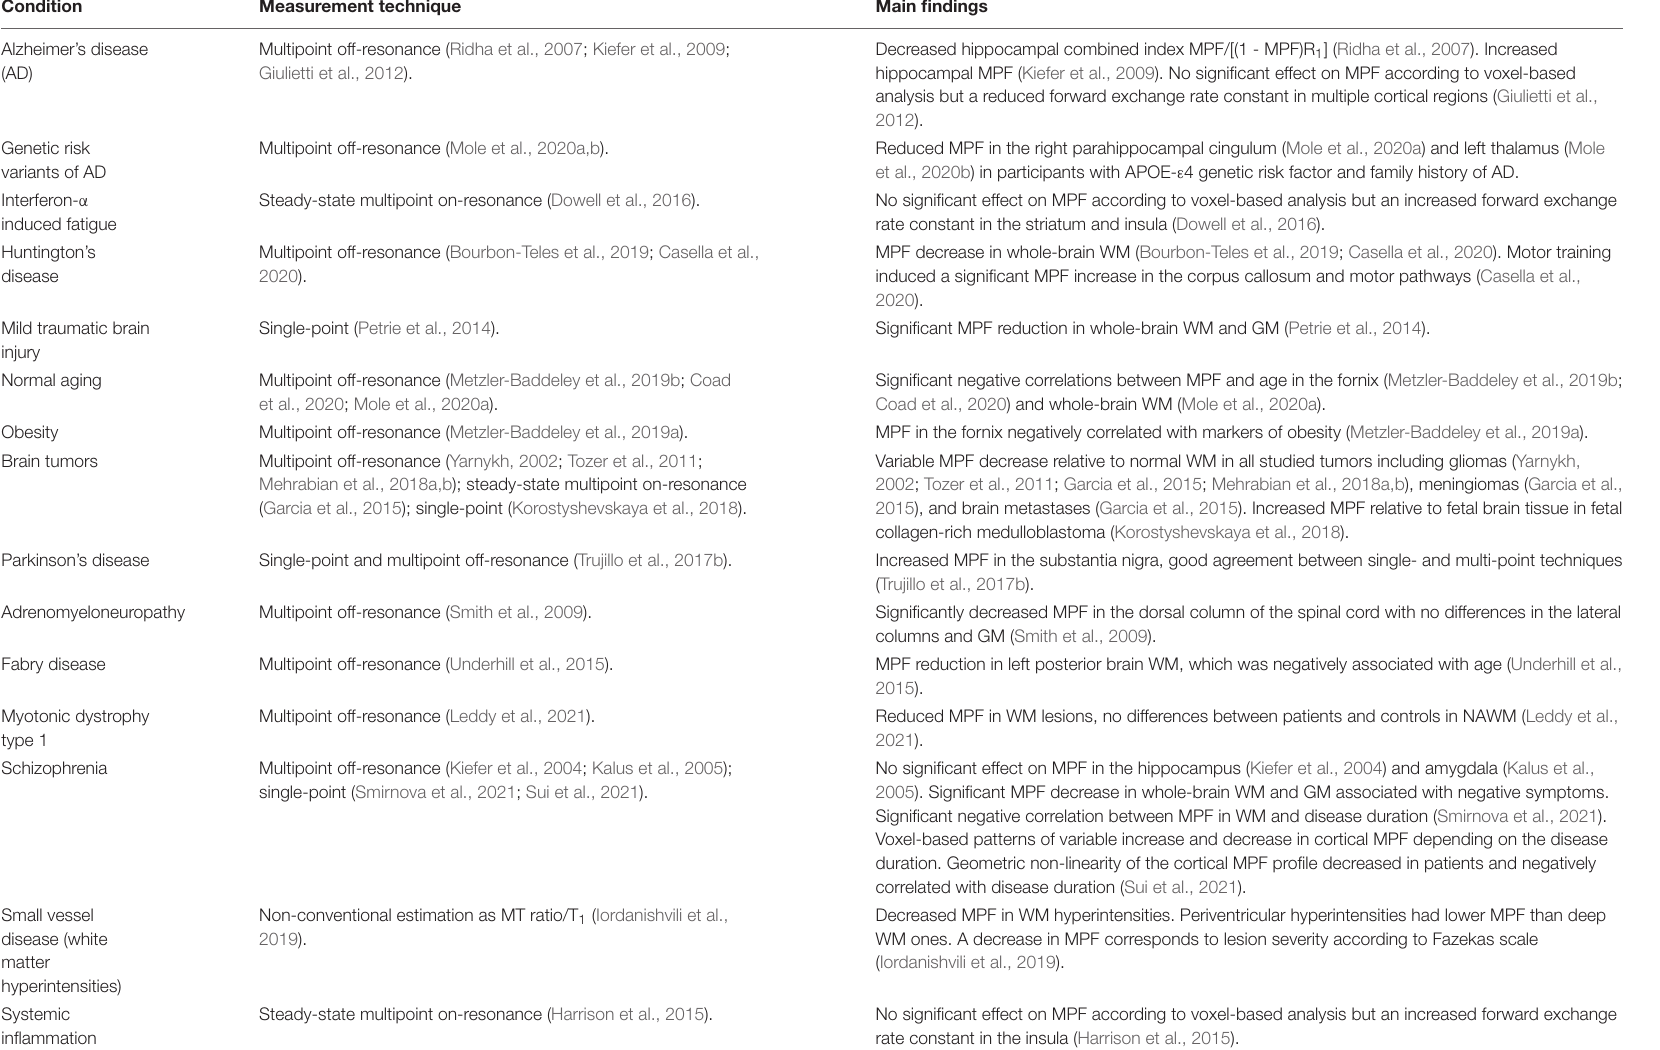
TABLE 1 | Summary of MPF applications in human conditions other than multiple sclerosis (MS).